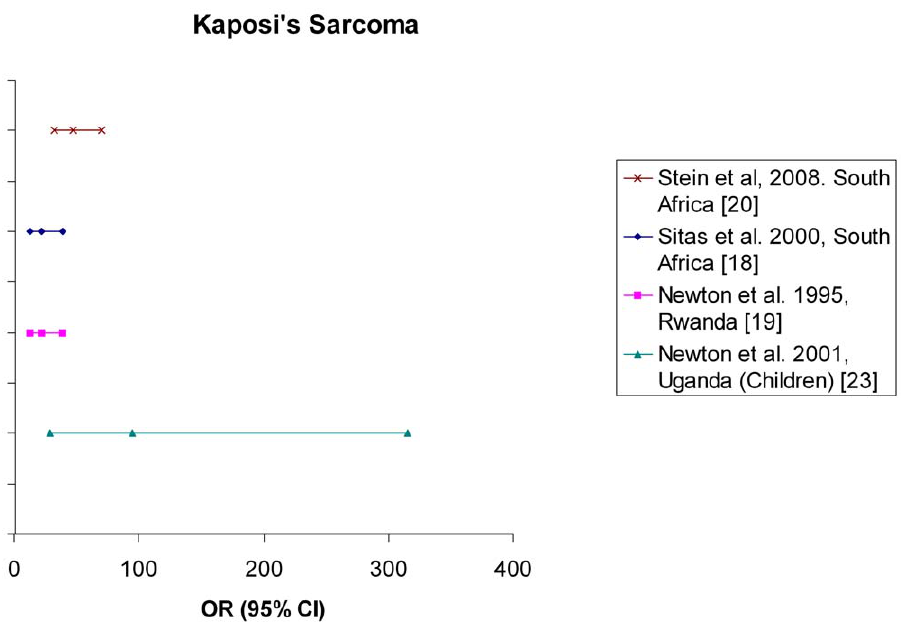
Figure 1. Odds Ratio (OR) and corresponding 95% confidence interval (95% CI) for the association between Kaposi sarcoma and HIV in sub-Saharan Africa.